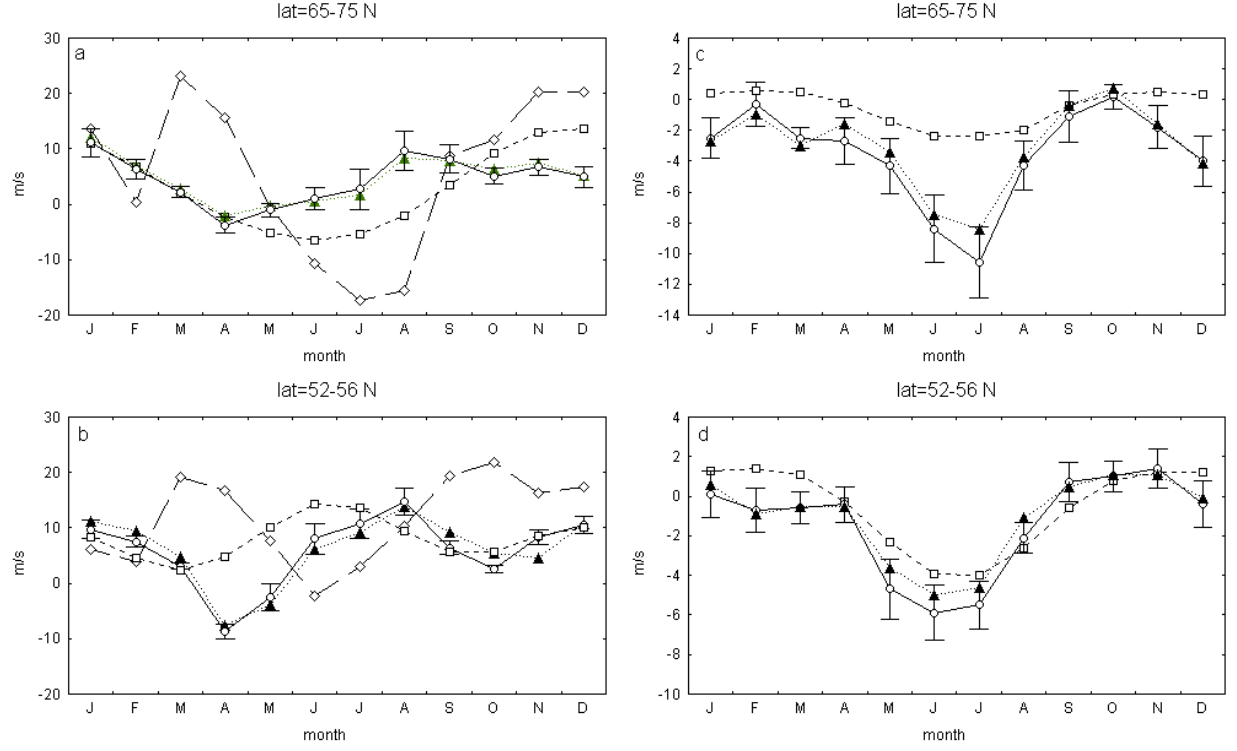
Fig. 5. The zonally averaged seasonal course of the prevailing wind at 90km; the error bars correspond to the r.m.s. (standard) errors: ( a ),( b ) - zonal wind (eastward positive), ( c ),( d ) –meridional wind (northward positive). − o − experimental data, −− HWM-93, ... N ...GEWM-I, −♦−